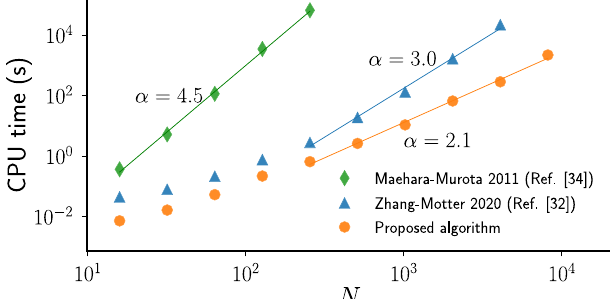
Fig. 1 Computational costs of different simultaneous block diagonalization algorithms as functions of matrix size N . The computational costs of all three algorithms scale as N α for large N . However, the algorithm proposed here has the smallest exponent α , which translates to order-of-magnitude speedups already for moderate matrix